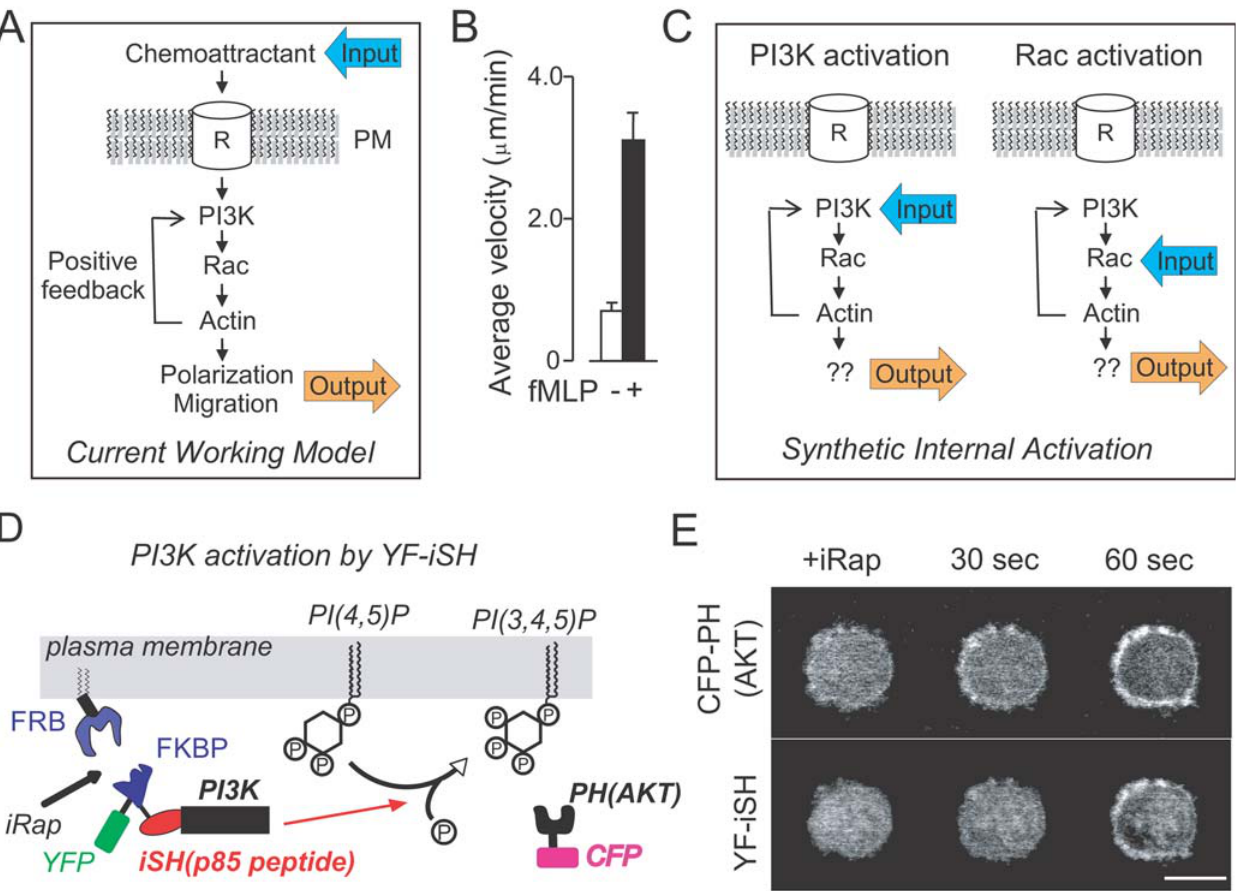
Figure 1. Synthetic activation of endogenous PI3K in HL60 neutrophil cells. (A) Working model for a local positive feedback loop that triggers cell polarization, migration and chemotaxis. (B) fMLP-induced cell migration was quantified by analyzing cell velocity before and after fMLP addition to differentiated HL-60 cells. Mean 6 S.E.M. (p , 0.0001, n=16 from two independent experiments). (C) Schematic representation of the synthetic activation of endogenous PI3K and Rac. If the feedback model is correct, activation of either endogenous PI3K or Rac should trigger polarization and migration. (D) Illustration of the synthetic PI3K activation system. iRap brings p85 derived YF-iSH together with the catalytic subunit of PI3K, p110, to the plasma membrane. Due to the induced proximity of PI3K to PIP 2 substrates in the plasma membrane, PI3K produces PIP 3 by phosphorylating PIP 2 . (E) Dual color fluorescent images of differentiated HL-60 cells show that iRap-induced YF-iSH translocation leads to rapid production of PIP3. Cells are shown every 30 seconds before and after iRap addition. Top: CFP-PH(AKT), Bottom: YF-iSH. Scale bar, 10 m m.